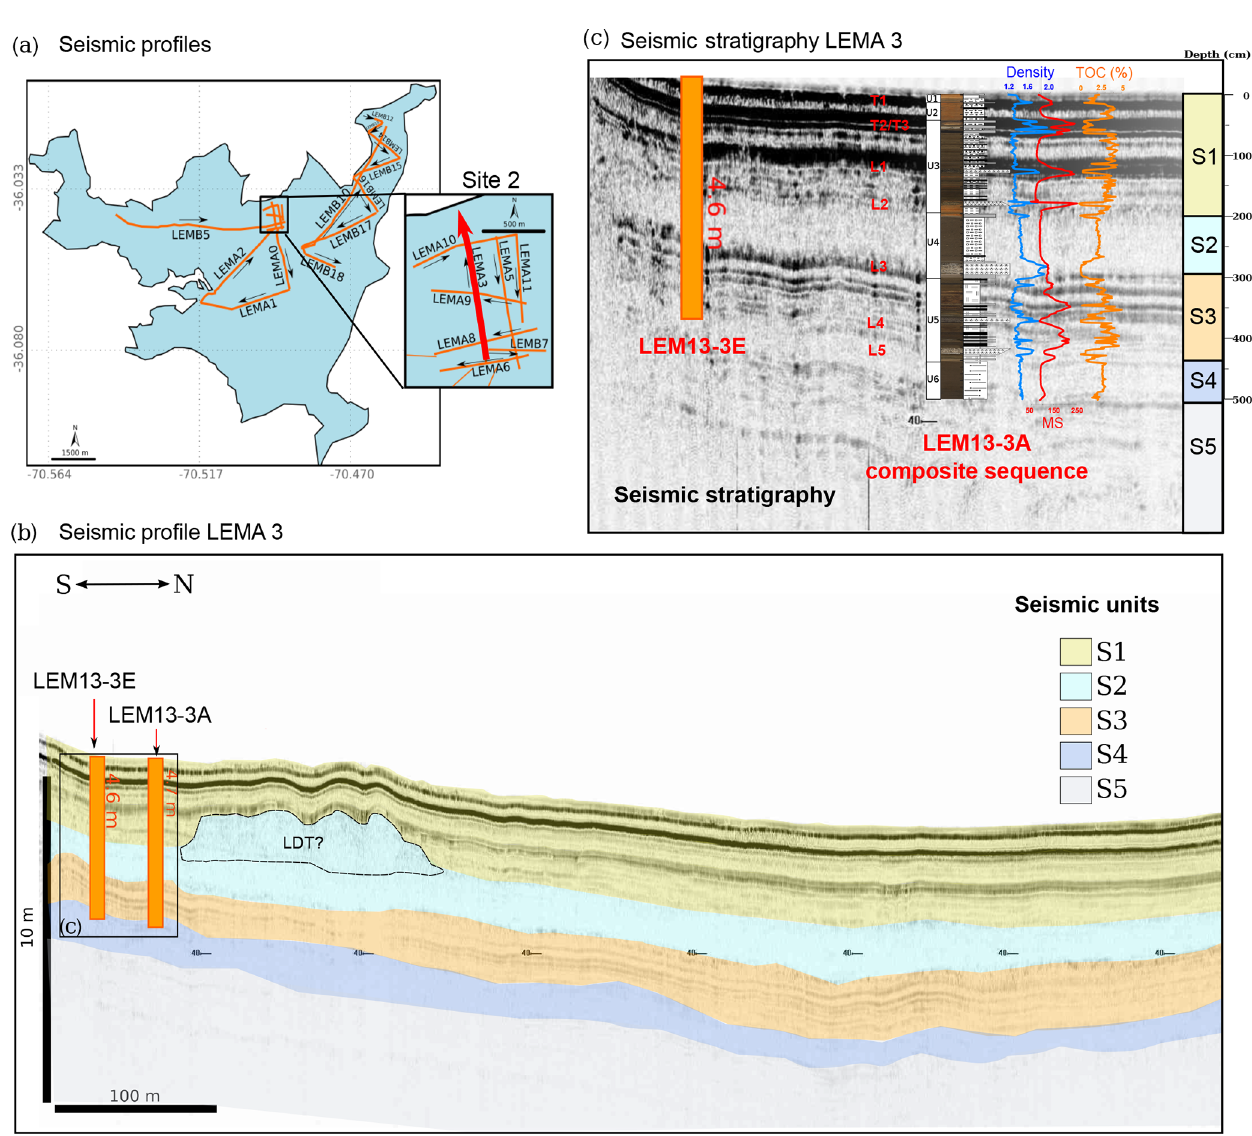
Figure 6. Seismic-to-core correlation and seismic to lithostratigraphic unit comparison. (a) LdM map showing the location of main seismic lines with line numbers. (b) S–N 3.5kHz seismic profile crossing LEMA 3 (red line in Fig. 6a). We recognize five different seismic units (S1 to S5), based on the characteristics of seismic reflectors and correlated with lithostratigraphic units in northern areas of LdM. Rectangles mark detailed views shown in Fig. 5c. (c) Seismic-to-core correlation of site 2 along the cross N–S reflection seismic profile LEMA 3. The seismic units correspond to the retrieved sequence, including banded to laminated lake sediments with intercalated mass wasting deposits (transparent to homogeneous seismic facies), volcanic layers (main reflectors) and coarse lacustrine/alluvial facies at the base (see